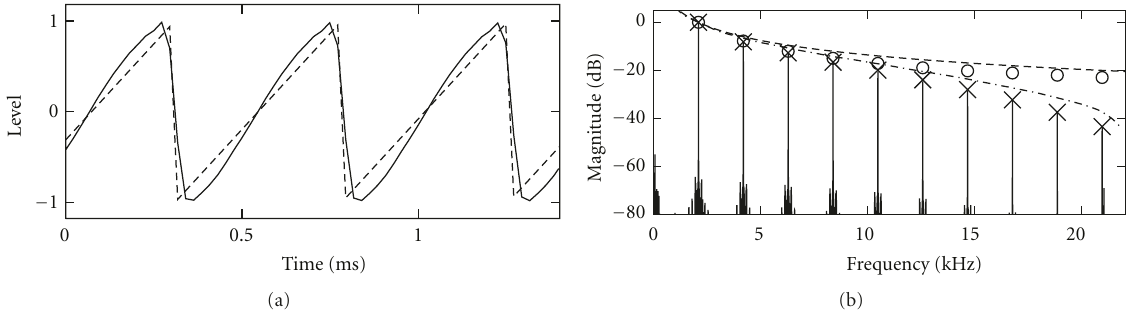
Figure 2: (a) Waveform and (b) spectrum of the recorded Moog sawtooth having f 0 = 2 . 096kHz. In (b), the crosses indicate the magnitudes of the waveform harmonics, the circles represent the magnitudes of the frequency-scaled harmonics of the recorded sawtooth waveform having f 0 = 220 . 62Hz, and the dash-dotted line is the magnitude-shifted spectral envelope of the sawtooth oscillator output for f 0 = 220 . 62Hz. The dashed line represents the waveform and the spectral envelope of the textbook sawtooth in (a) and (b), respectively.